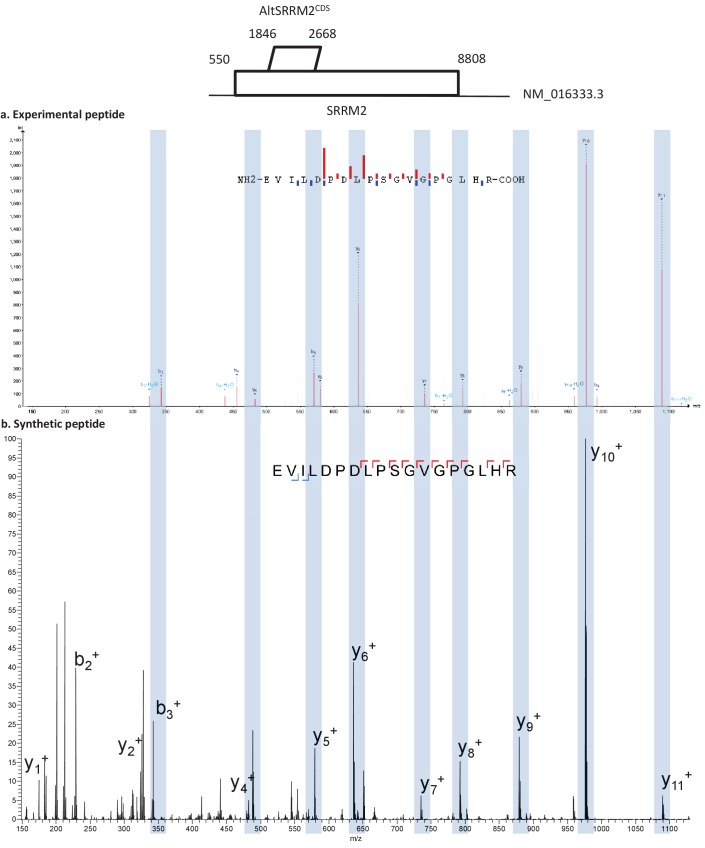
Spectra validation for altSRRM2CDS.Example of validation for altSRRM2CDS-specific peptide EVILDPDLPSGVGPGLHR. (a) Experimental MS/MS spectra (PeptideShaker graphic interface output). (b) MS/MS spectra of the synthetic peptide. Matching peaks are shown with blue masks. A diagram of the transcript with its accession number and the localization of the altORF and the CDS is shown at the top.